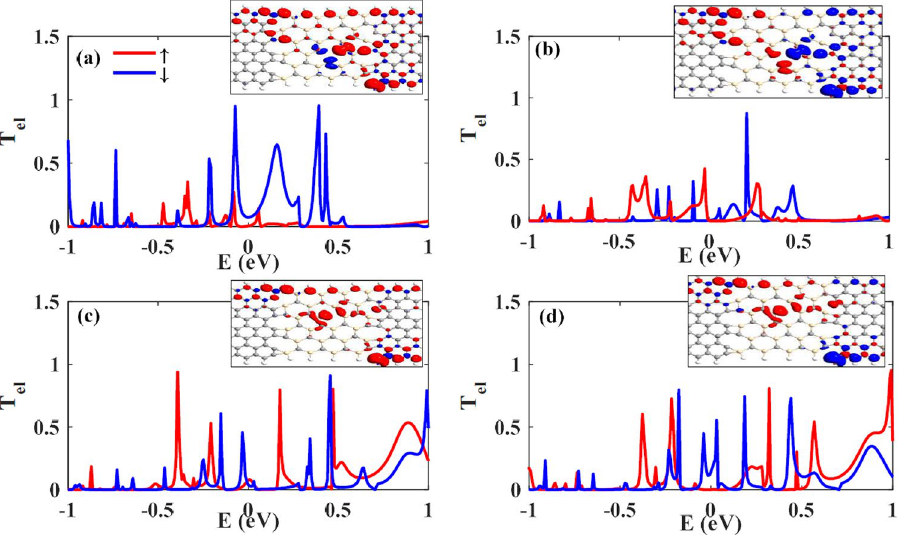
Figure 4. The spin-dependent electron transmission coefficients of ( a ) and ( b ) Si-defected SiCNRs in P and AP configurations and ( c ) and ( d ) C-defected SiCNRs in P and AP configurations, respectively. The insets show the corresponding spin density diagram of the junctions. Red (blue) color represents the spin-up (-down) density and the mean values of spin densities are as the same as Fig.